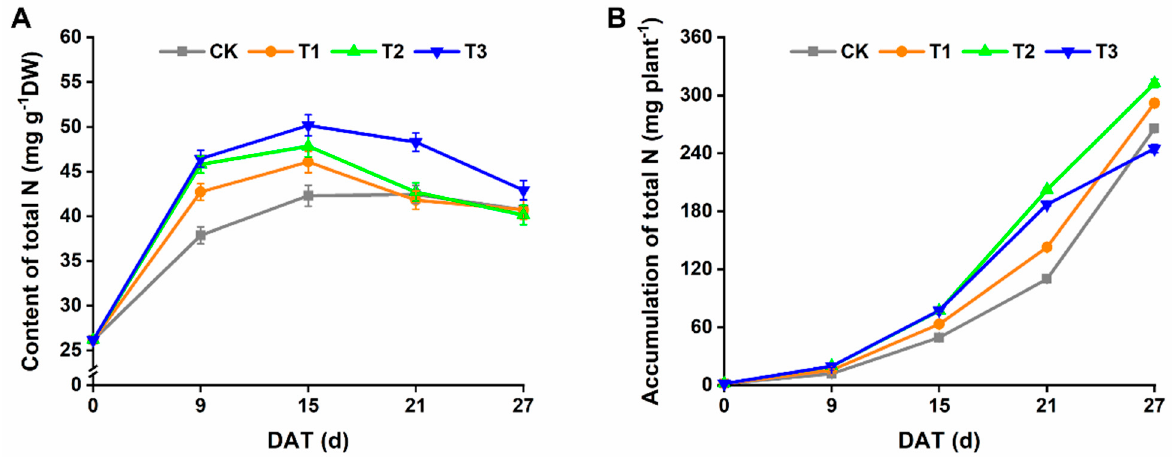
Figure 3. The content ( A ) and accumulation ( B ) of total N affected by different NH4 + /NO 3 − ratios during the growth period of Chinese kale. CK = 0/100, T1 = 10/90, T2 = 25/75, T3 = 50/50. DW, dry weight; DAT, days after treatment. The data represent mean ± SE ( n = 3).